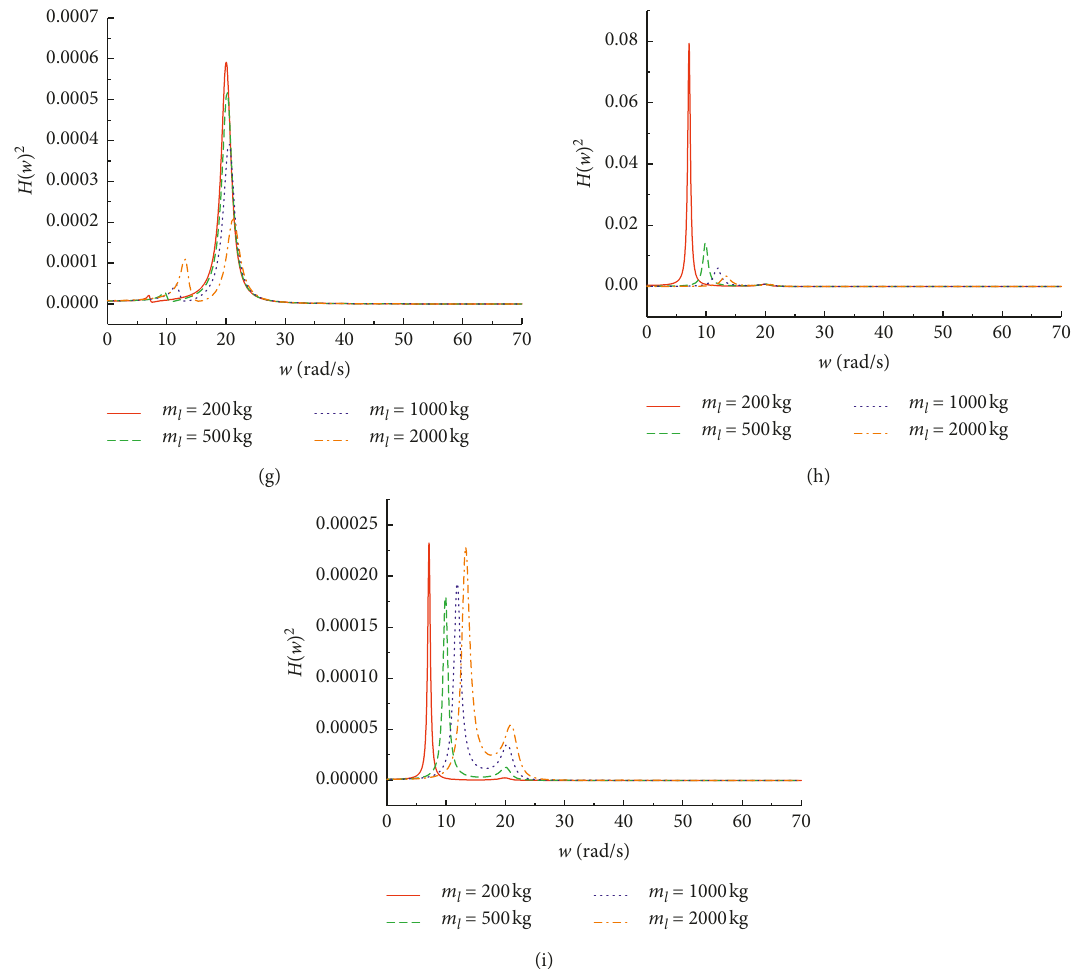
Figure 12: Transfer function of coupled system considering connection structure ((a, b, c) affected by frequency of connection structure; (d, e, f) affected by damping coefficient of connection structure; (g, h, i) affected by mass of connection structure). (a) Transfer function of primary structure. (b) Transfer function of connection structure. (c) Transfer function of secondary structure. (d) Transfer function of primary structure. (e) Transfer function of connection structure. (f) Transfer function of secondary structure. (g) Transfer function of primary structure. (h) Transfer function of connection structure. (i) Transfer function of secondary